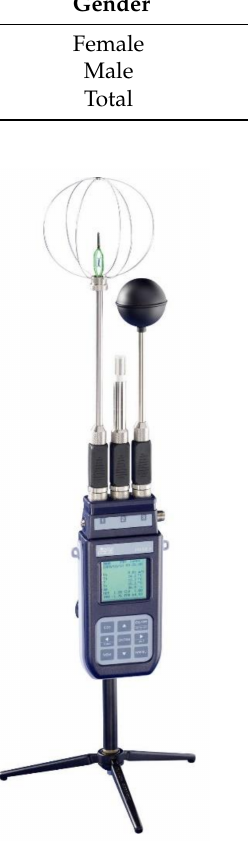
Figure 5. Thermal microclimate station. The operative temperature defined as “the uniform temperature of an imaginary black enclosure in which an occupant would exchange the same amount of heat by radiation and convection as in the actual non uniform environment”